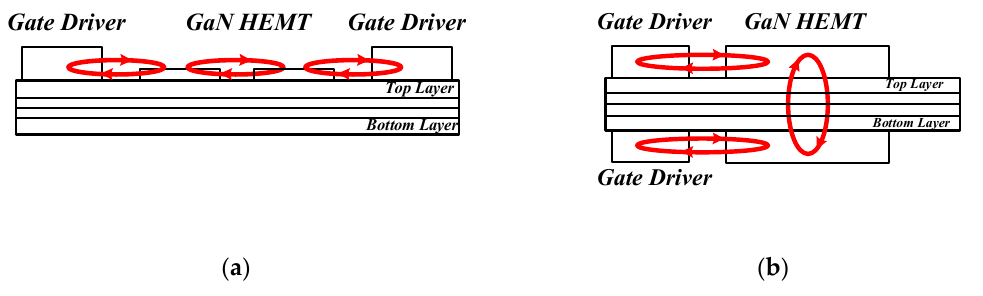
Figure 3. ( a ) Lateral structure of GaN HEMT; ( b ) vertical structure of GaN HEMT.